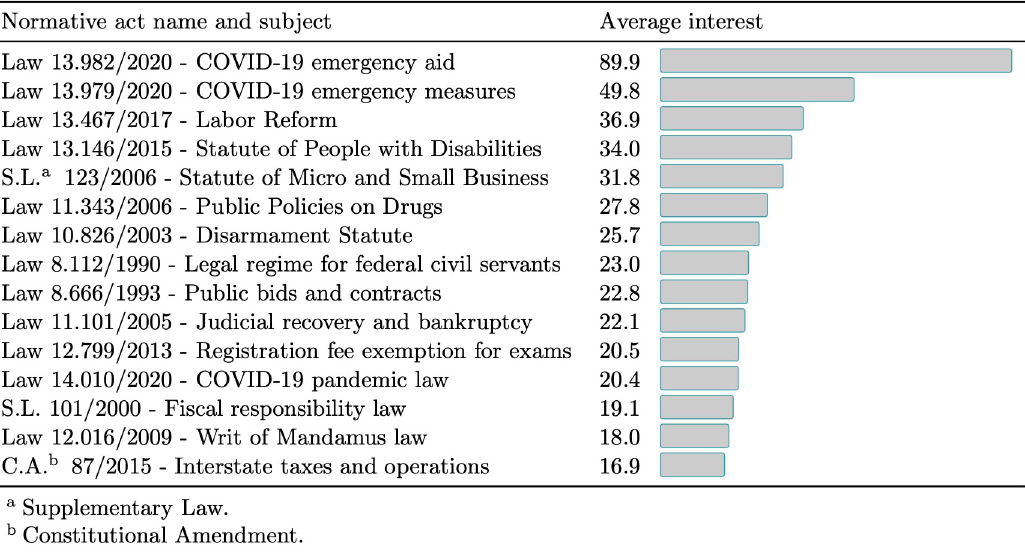
Fig 9. Average interest of normative acts on Google